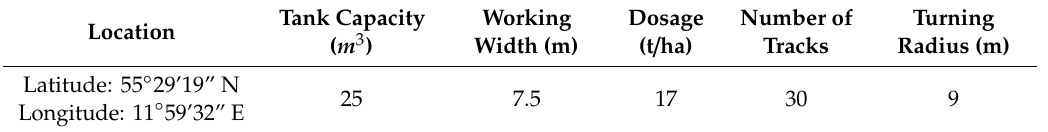
Table 11. Information regarding the fertilizing operation A.